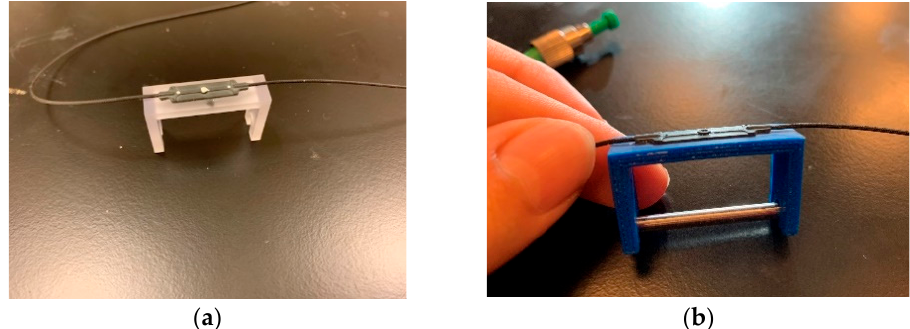
Figure 2. U ‐ shaped corrosion sensor with an FBG sensor bonded to its upper surface. ( a ) W/O dumbbell ‐ shaped component. ( b ) With dumbbell ‐ shaped component.